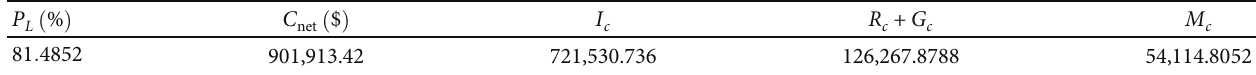
Table 7: The most optimal